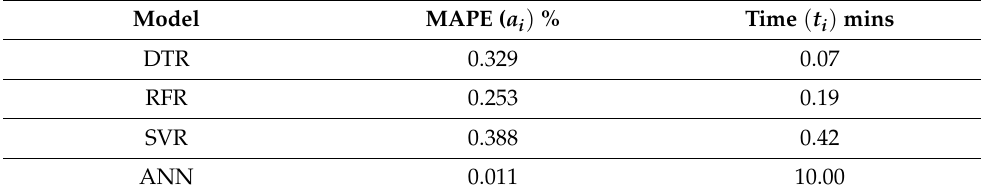
Table 3. Accuracy and time performance characteristics of the examined methods.